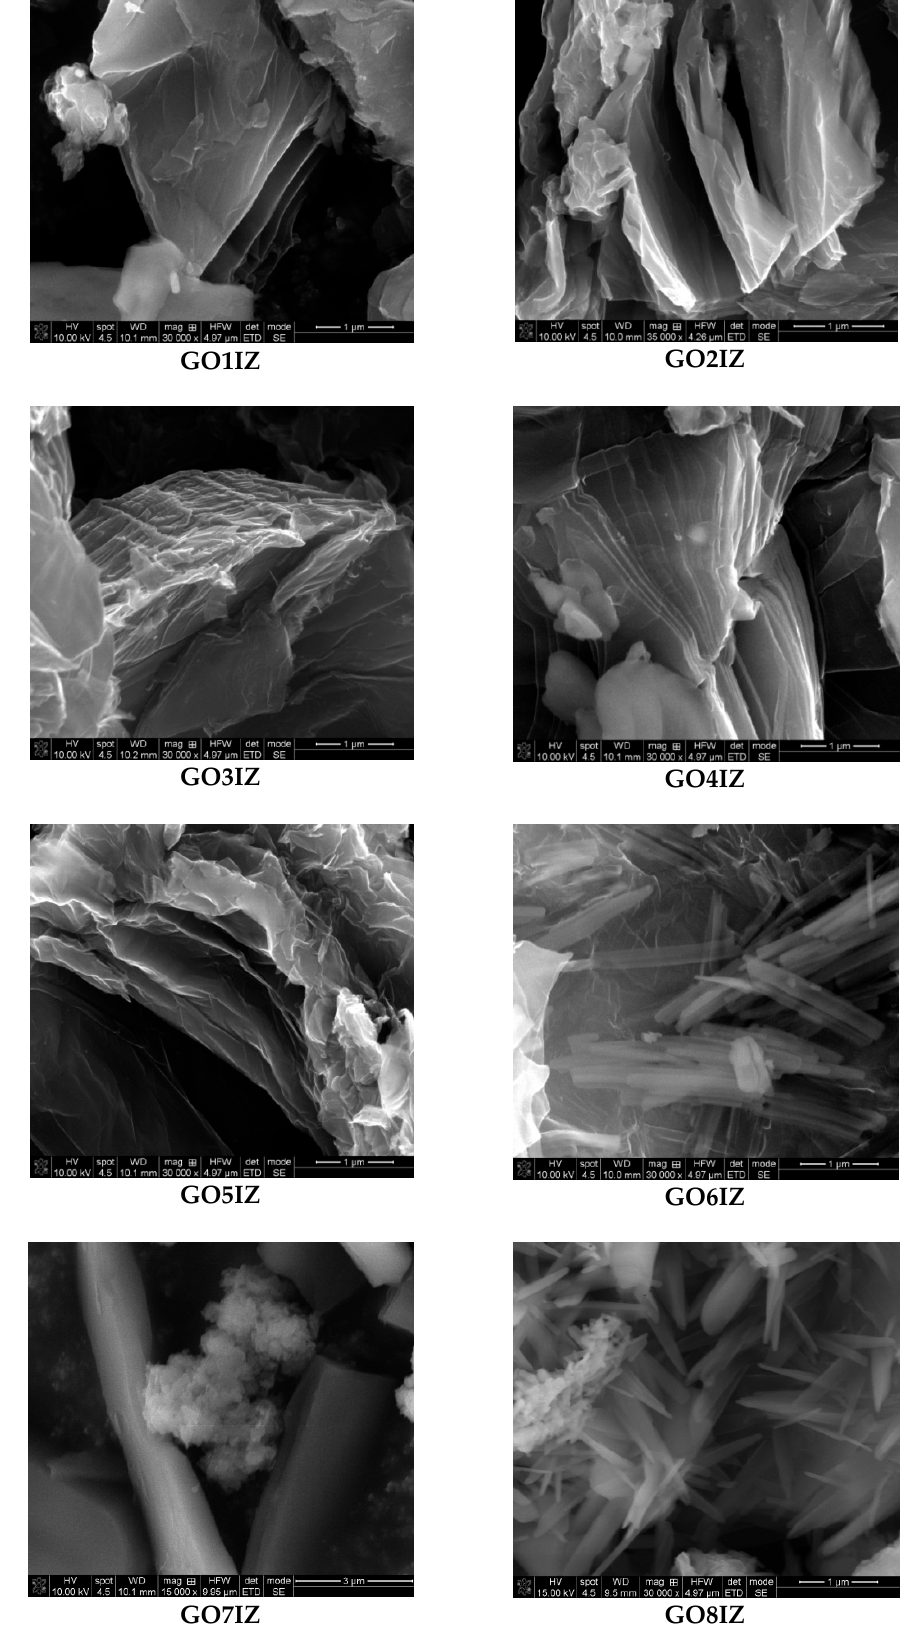
Figure 5. SEM pictures of samples GO1IZ – GO8IZ